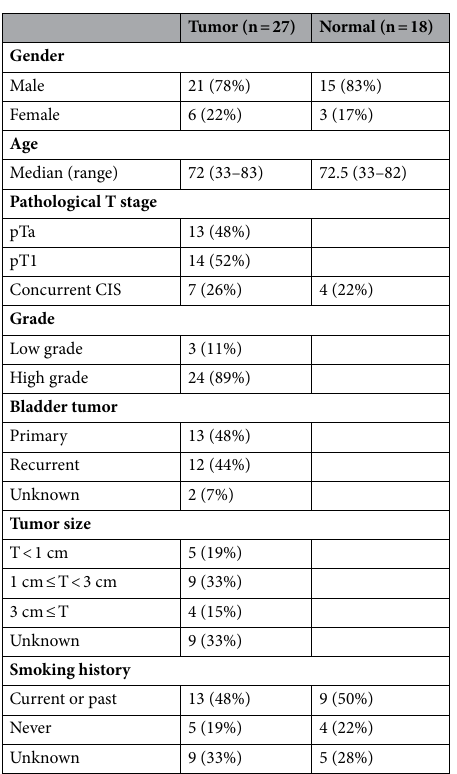
Table 1. Patients’ characteristics of tumor and normal samples analyzed in this